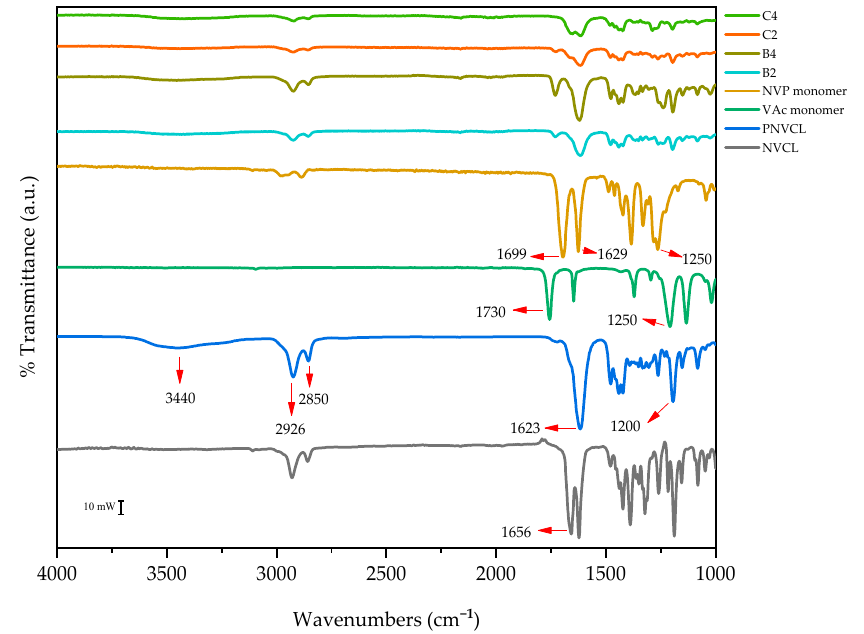
Figure 4. FTIR spectra of ( top – bottom ) P(NVCL60-NVP40), P(NVCL80-NVP20), P(NVCL60-VAc40), P(NVCL80-VAc20), NVP monomer, VAc monomer, PNVCL, and NVCL. The monomers displayed characteristic absorption bands at 1730 cm − 1 (VAc), 1656 cm − 1 (NVCL), 1640 cm − 1 , and 2800 cm − 1 (NVP). These absorption bands were assigned to